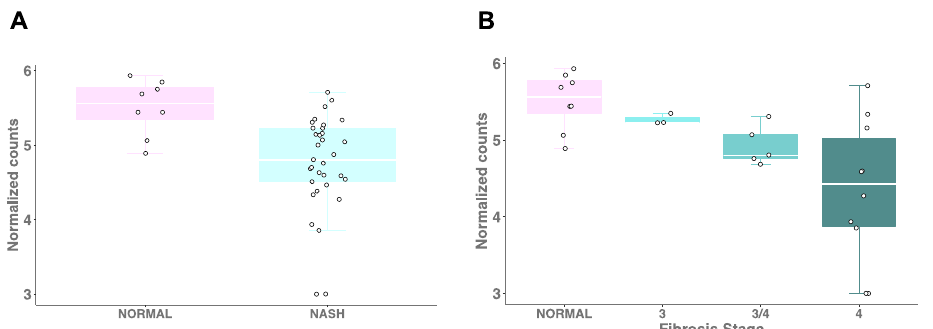
Figure 2. Hepatic PEMT expression is reduced in postmenopausal women with NAFLD and fibrosis. ( A ) PEMT expression in postmenopausal women with inflammation and fibrosis (i.e., NASH (n = 31) and normal liver histology (n = 8). ( B ) PEMT expression in postmenopausal NAFLD patients with varying degrees of fibrosis.